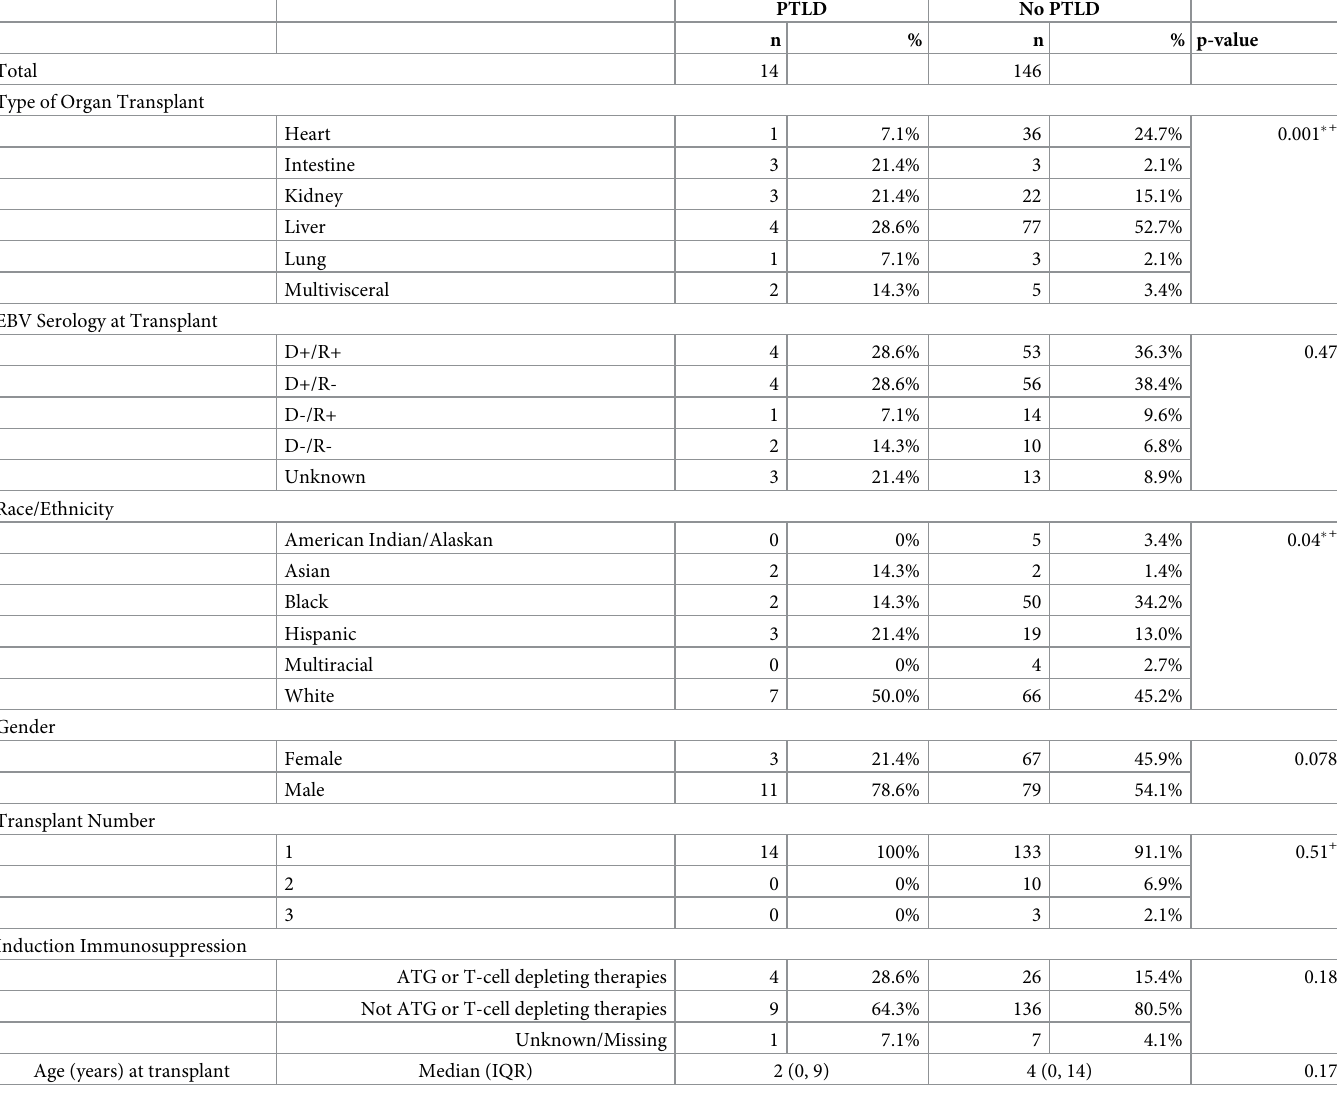
Table 2. The characteristics of children who had PTLD at any time post-transplant are compared to children who had no PTLD. This is limited to the children who had any EBV DNAemia after transplant. The incidence of PTLD is shown for each demographic